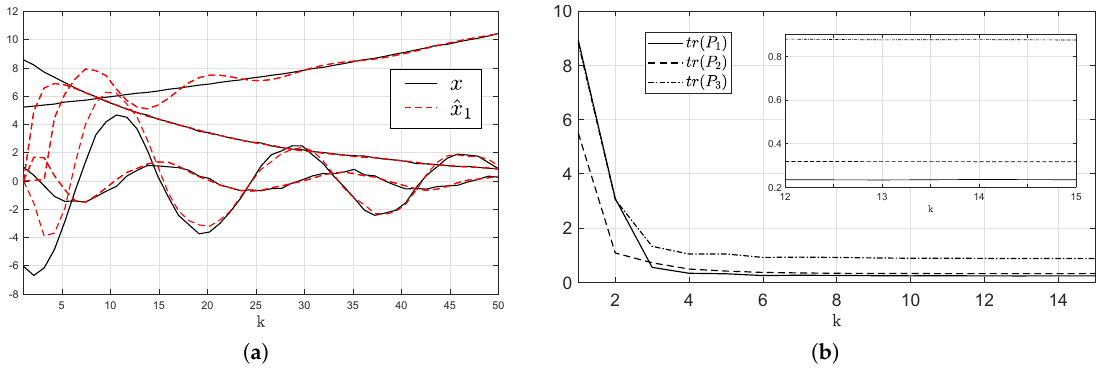
Figure 3. Results of Example 1. ( a ) Evolution of the system state and agent 1 estimates (in dashed lines); ( b ) Evolution of tr ( Q i , ρ ) for every